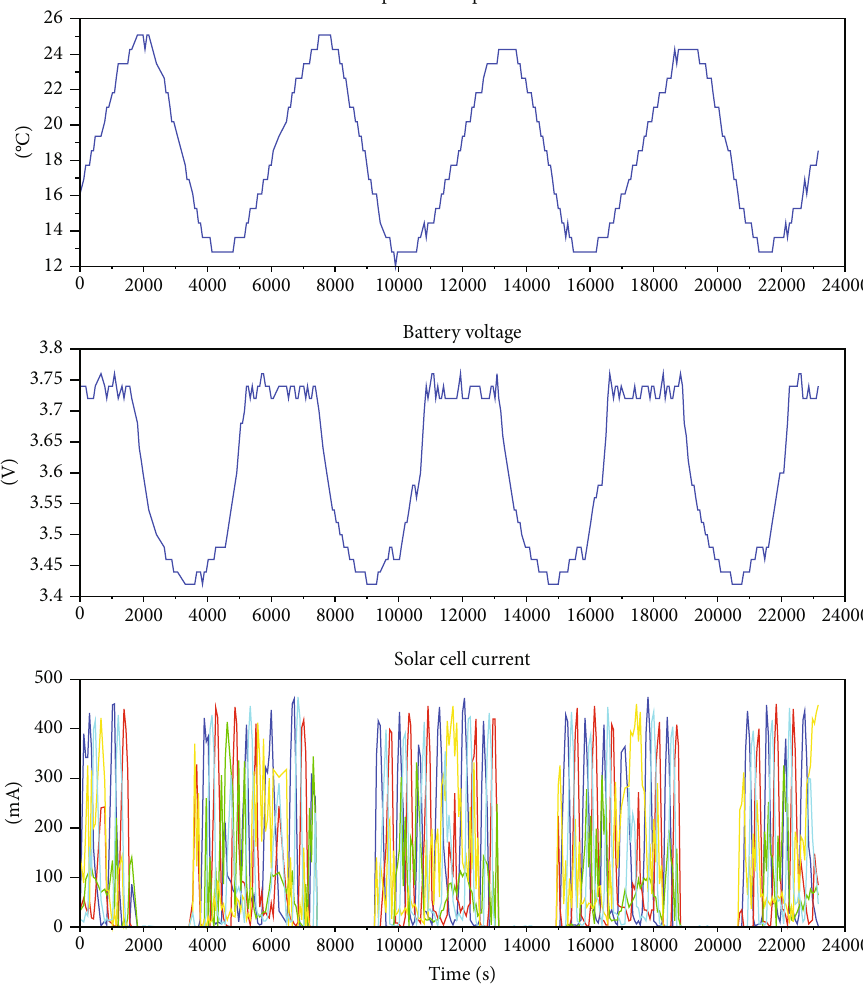
Figure 12: GPS receiver temperature and its relationship with accumulator voltage and solar cell current. Temperature is rounded to 1 ° C and current to 1 mA in the satellite; the current of the cells varies due to the satellite